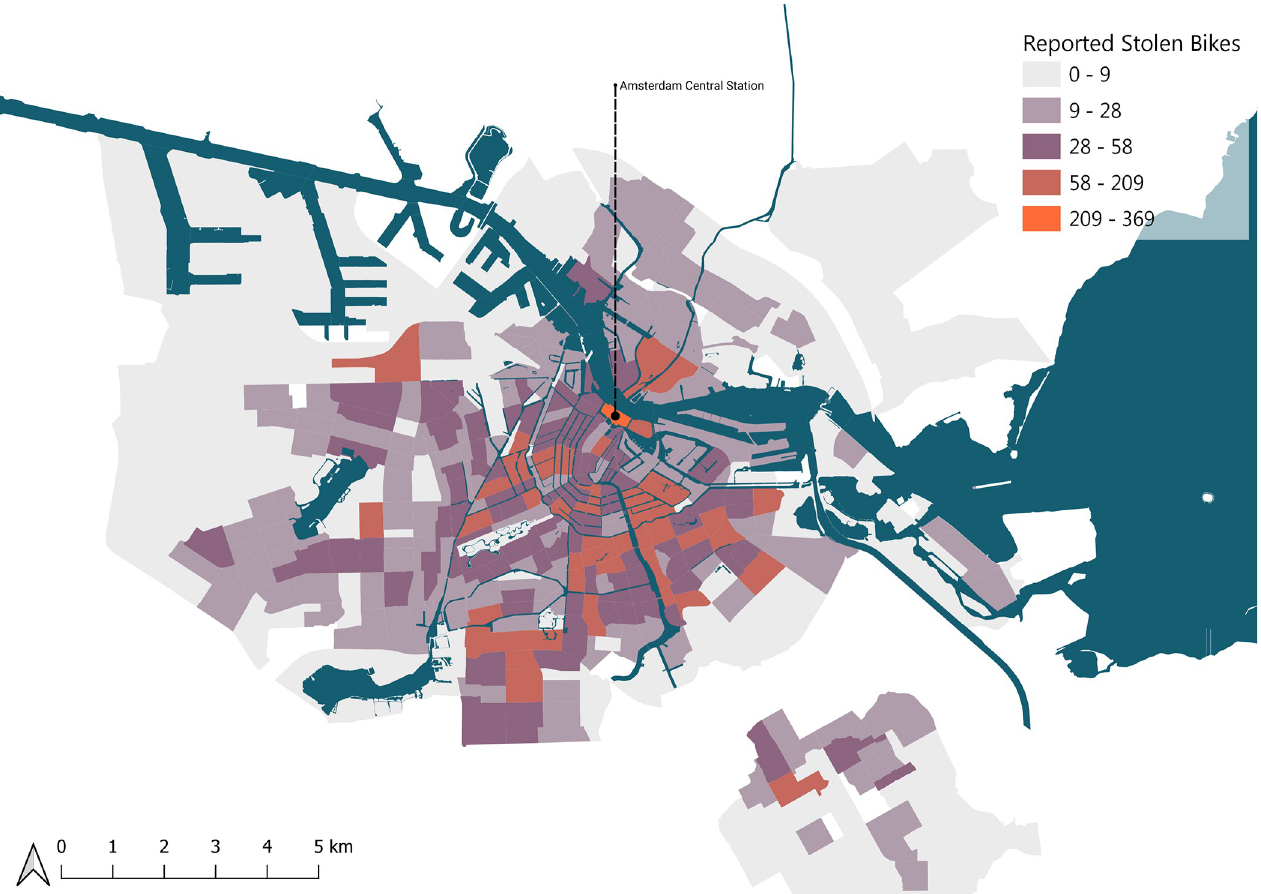
Fig 2. The number of reported bike thefts per neighborhood in Amsterdam (2019). Data from [15], base map data from